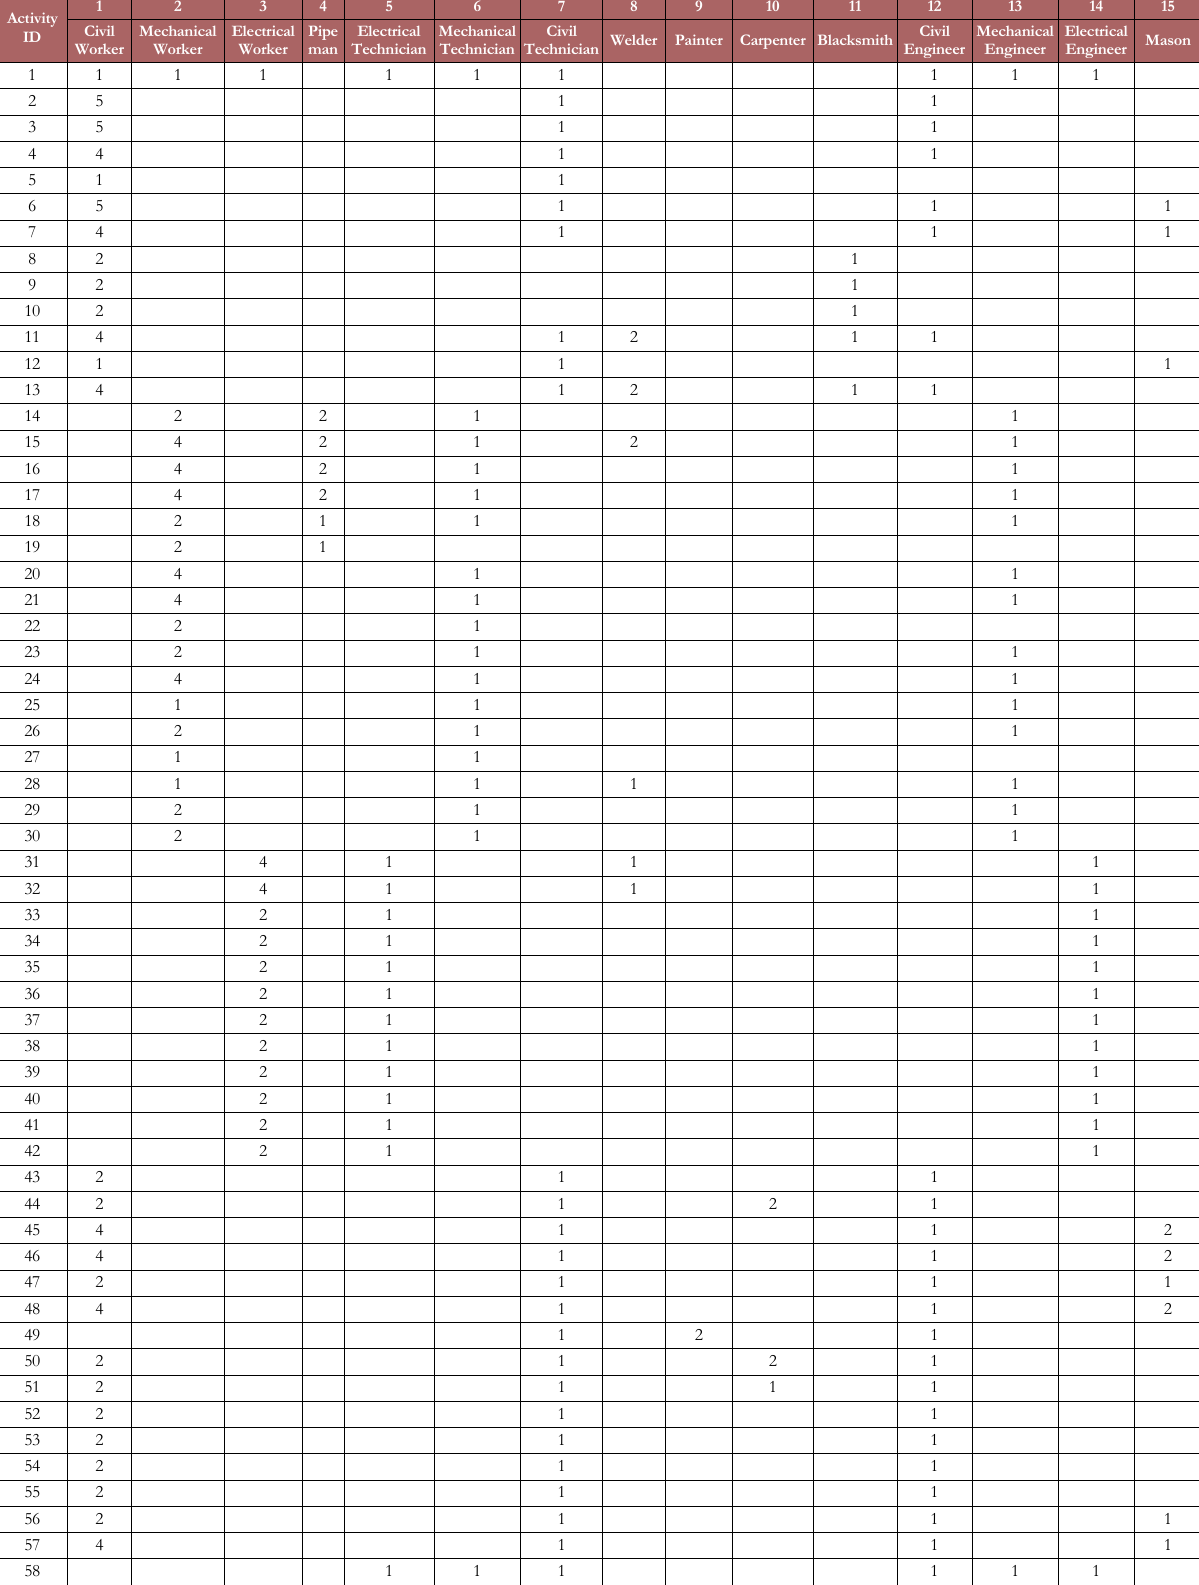
Table 7. Resource Usage of